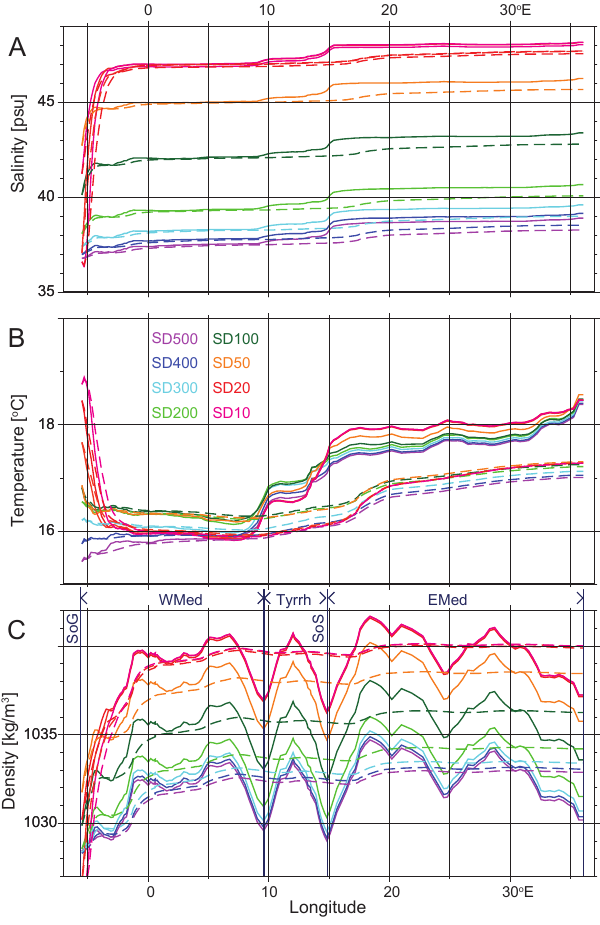
Figure 7. Latitude-depth-averaged profiles of salinity (a) , temper- ature (b) and density (c) for SD500–SD10. Dashed lines indicate the volume-averaged salinity/temperature/density of the volume be- tween the Strait of Gibraltar and the indicated longitude. Therefore, the values at 36 ◦ E are the averages of the whole basin. Indicated in (c) are the longitudinal ranges corresponding to the western basin (WMed), the Tyrrhenian Sea (Tyrrh), and the eastern basin (EMed) and location of the Strait of Gibraltar (SoG) and Strait of Sicily